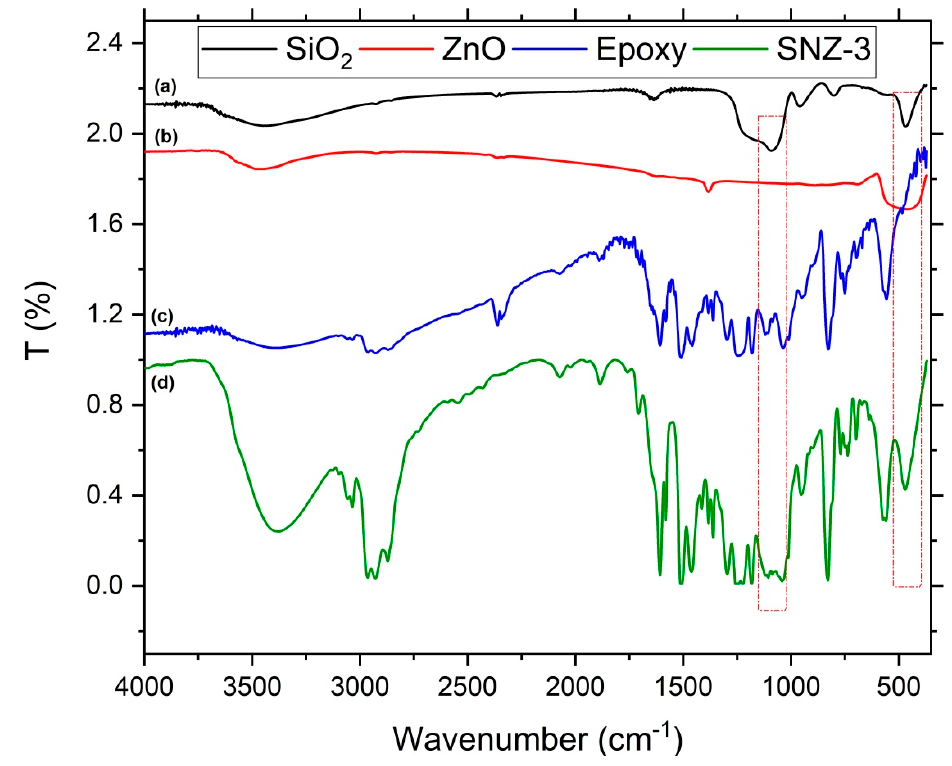
Figure 1. Fourier transform infrared (FTIR) spectra of ( a ) SiO 2 nanoparticles, ( b ) ZnO nanoparticles, ( c ) epoxy resin, and ( d ) SiO 2 /ZnO-modified epoxy coating (SNZ-3).